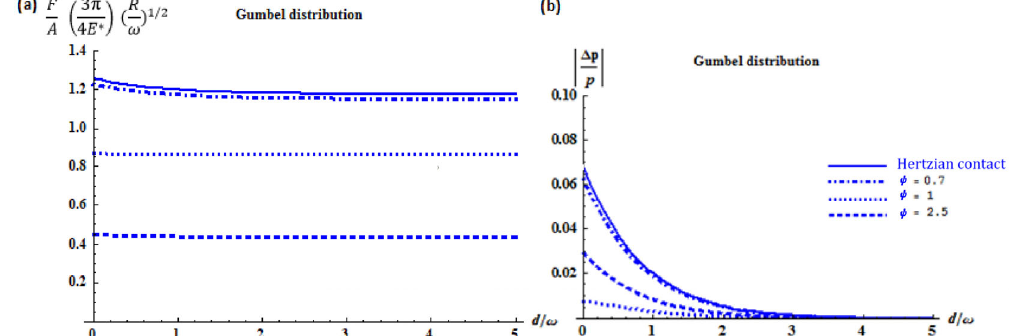
Fig. 6 (a) Pressure via separation and Elastic- plastic model as contact asperity. Variation of plasticity index changes the pressure since the real area of contact increases. (b) Relative change of pressure via separation. A fully elastic model such as Hertz model has the most pressure changes compared to elastic-plastic contacts.